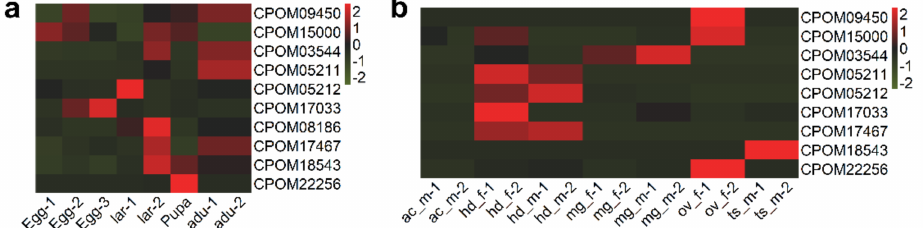
Figure 6. Expression pattern of positively selected P450s in different tissue ( a ) and different stages ( b ) of C. pomonella . The x -axis shows the different life stages ( a ) and tissues ( b ), and the y -axis shows the PSGs. The color of the grid represents the expression level of the PSGs in different tissues and stages. Key: lar = larva; adu = adult; ac = accessory gland; hd = head; mg = midgut; ov = ovary; ts = testis; m = male; f =